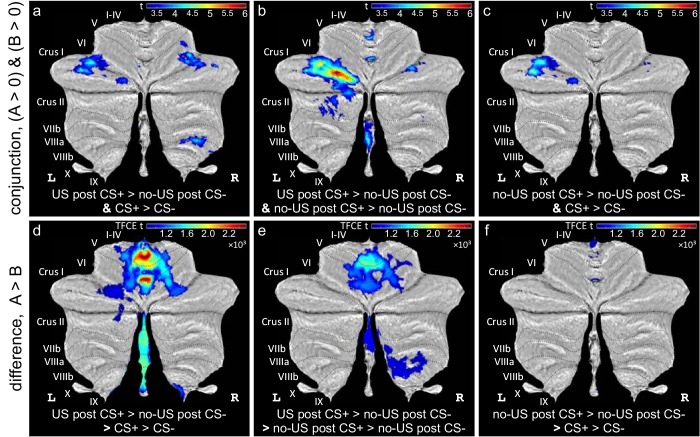
Comparison of cerebellar areas related to the presentation, the prediction and the omission of the aversive stimulus.(a–c) Common areas of cerebellar activation considering any two of the three main acquisition contrasts as revealed by conjunction analyses testing global null hypothesis; (d–f) significant differences in activation considering any two of the three main acquisition contrasts as revealed by F-tests (using TFCE; inverse tests do not show any significant activation). All data presented at a significance level of p<0.05 FWE-corrected. CS = conditioned stimulus; FWE = familywise error; TCFE = threshold-free cluster-enhancement; US = unconditioned stimulus; VOI = volumes of interest.